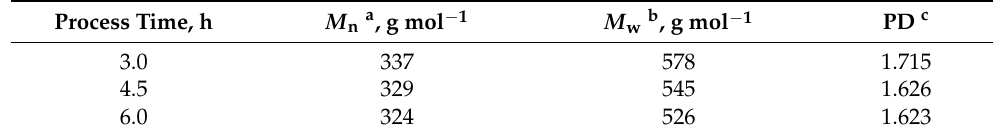
Table 8. The effect of time of spruce wood RSF over the 3RS450 catalyst at 225 ◦ C for 3 h on the molecular weight characteristics of the liquid products.